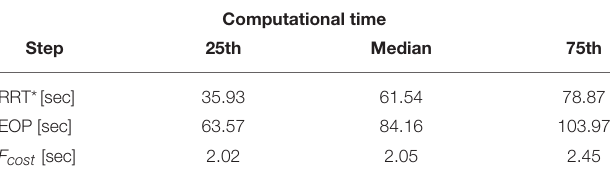
TABLE 3 | Results in term of computational time are